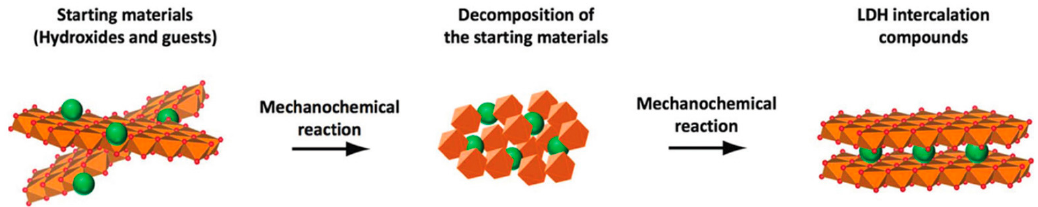
Figure 12. A schematic drawing of the formation of layered double hydroxides from raw materials by applying mechanochemical reaction. Reproduced with permission from reference [133].